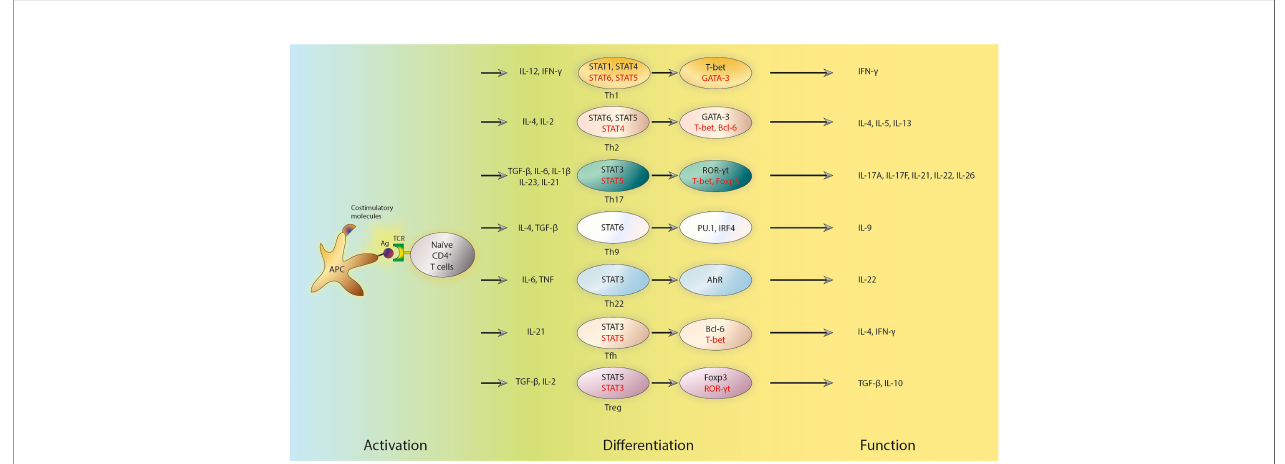
FIGURE 1 | Subsets, transcriptional regulators and key cytokines of Th cells. APCs activate naïve CD4 + T cells by presenting antigens. The activation also requires combination with costimulatory molecules, which triggers the production of polarizing cytokines and subsequent differentiation of naïve CD4 + T cells into distinct effector Th and Treg subsets. The polarized differentiations are characterized by lineage-speci fi c regulators and the secretion of key cytokines. The early response of those T cells is regulated by STATs. STATs can further in fl uence the expression of master transcription factors. Positive regulators are shown in black, while negative regulators are shown in red. Th cells, T helper cells; APCs, antigen presenting cells; Treg cells, regulatory T cells; STAT, signaling transducer and activation of transcription molecules; Ag, antigen; TCR, T-cell receptor; IL, interleukin; TGF- b , transforming growth factor b ; TNF, tumor necrosis factor; Tfh cells, follicular T helper cells; T-bet, T-box transcription factor 21; ROR- g t, retinoic acid-related orphan receptor g t; Foxp3, forkhead box P3; IRF4, Interferon Regulatory Factor 4; IFN- g , interferon g